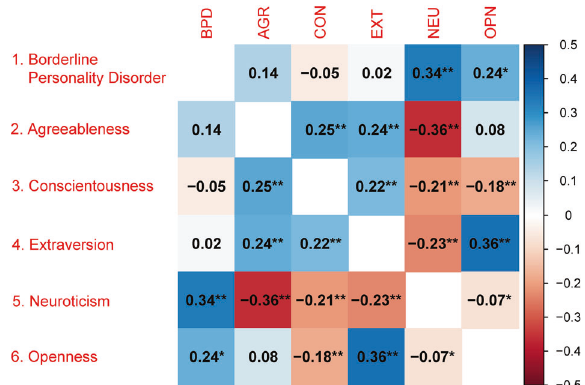
Fig. 1 Genetic correlations between Borderline Personality Dis- order and the Big Five personality traits. Note: Red fi elds indicate negative and blue fi elds indicate positive genetic correlations. * p < 0.05, ** p < 0.0033 (0.05/15 tested correlations). Neuroticism was